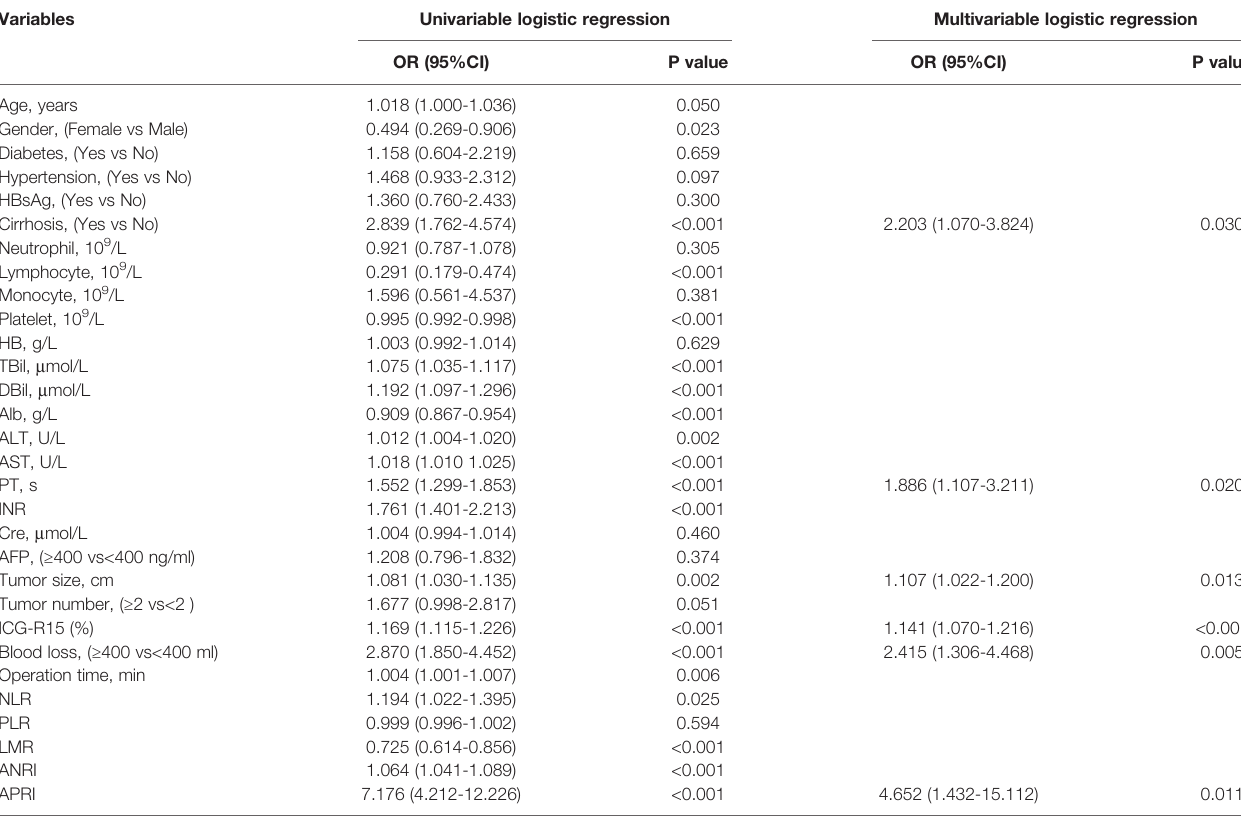
TABLE 2 | Univariable And Multivariable Analyses for preoperative and intraoperative variables of PHLF according to ISGLS criteria in the training cohort.